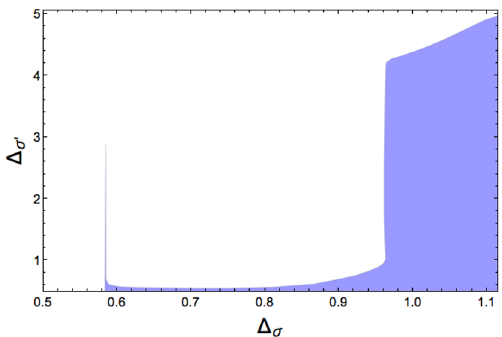
Figure 1 . Bound on the scaling dimension of the subleading T-parity odd operator. We assume that the spectrum contains only one relevant T-parity even operator. The numerics is performed at Λ = 13